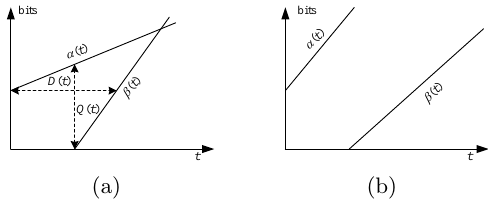
Figure 3: Constraint of arrival and service curves: (a) constraint satisfied, (b) constraint